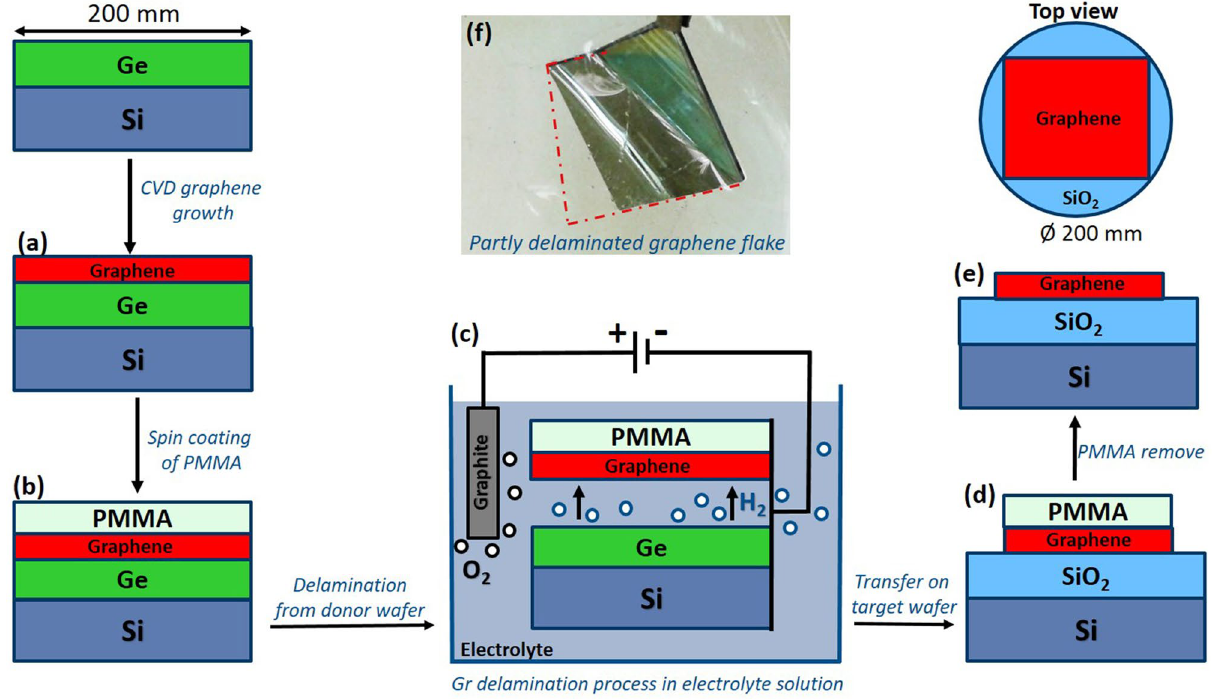
Figure 9. General graphene growth and transfer scheme: ( a ) graphene growth on 200 mm Ge/Si wafers by CVD process; ( b ) spin-coating of PMMA polymer on top of graphene; ( c ) electrochemical delamination process in order to detach graphene from the donor wafer; ( d ) transfer of detached graphene flake on target wafer; ( e ) transferred graphene on target wafer after the remove of support PMMA layer: cross-section and top view; ( f ) image of partly delaminated graphene flake during the delamination